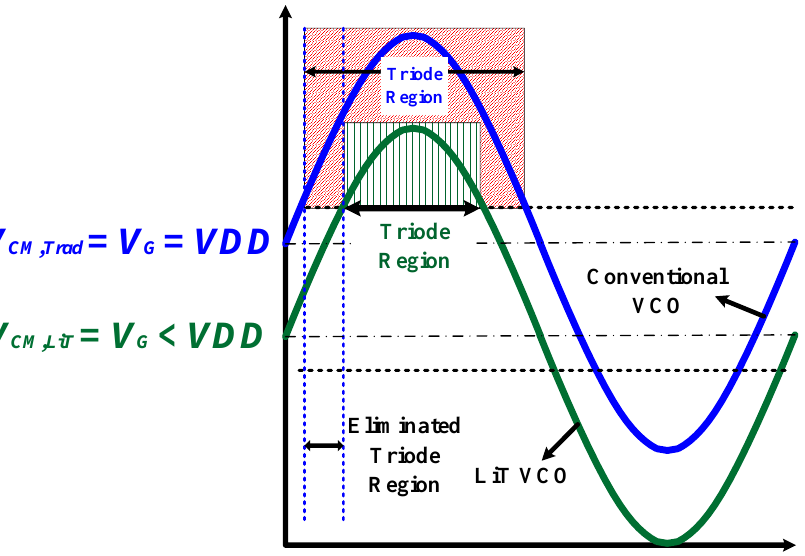
Figure 4. Swing of the Gate voltage in a conventional VCO and linear transconductance VCO.